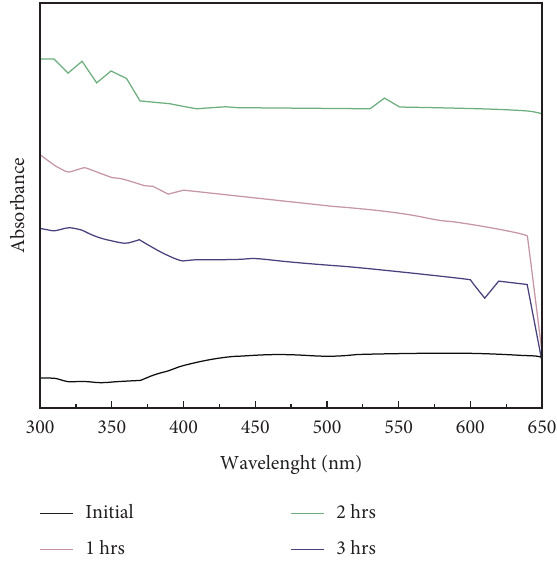
Figure 2: UV-Vis spectroscopic analysis of TiO